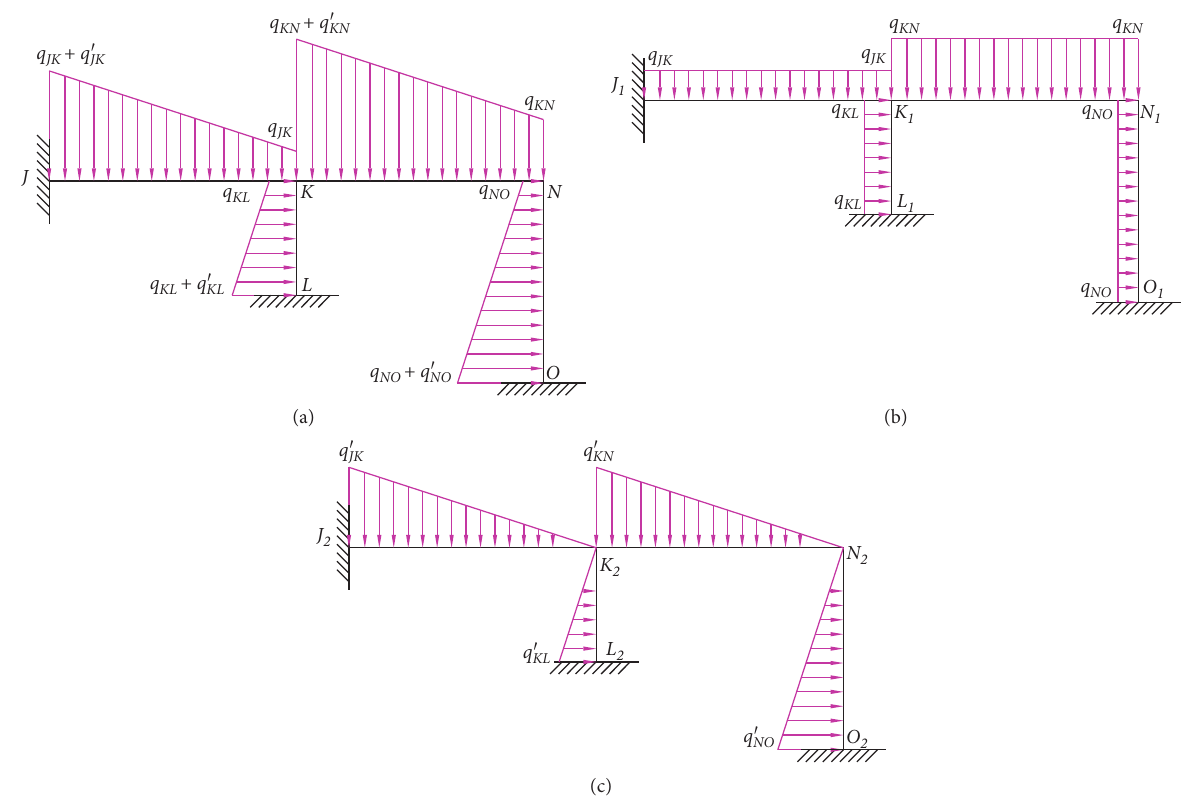
Figure 9: The load decomposition of JKLNO : (a) trapezoidal load; (b) rectangular load; (c) triangular